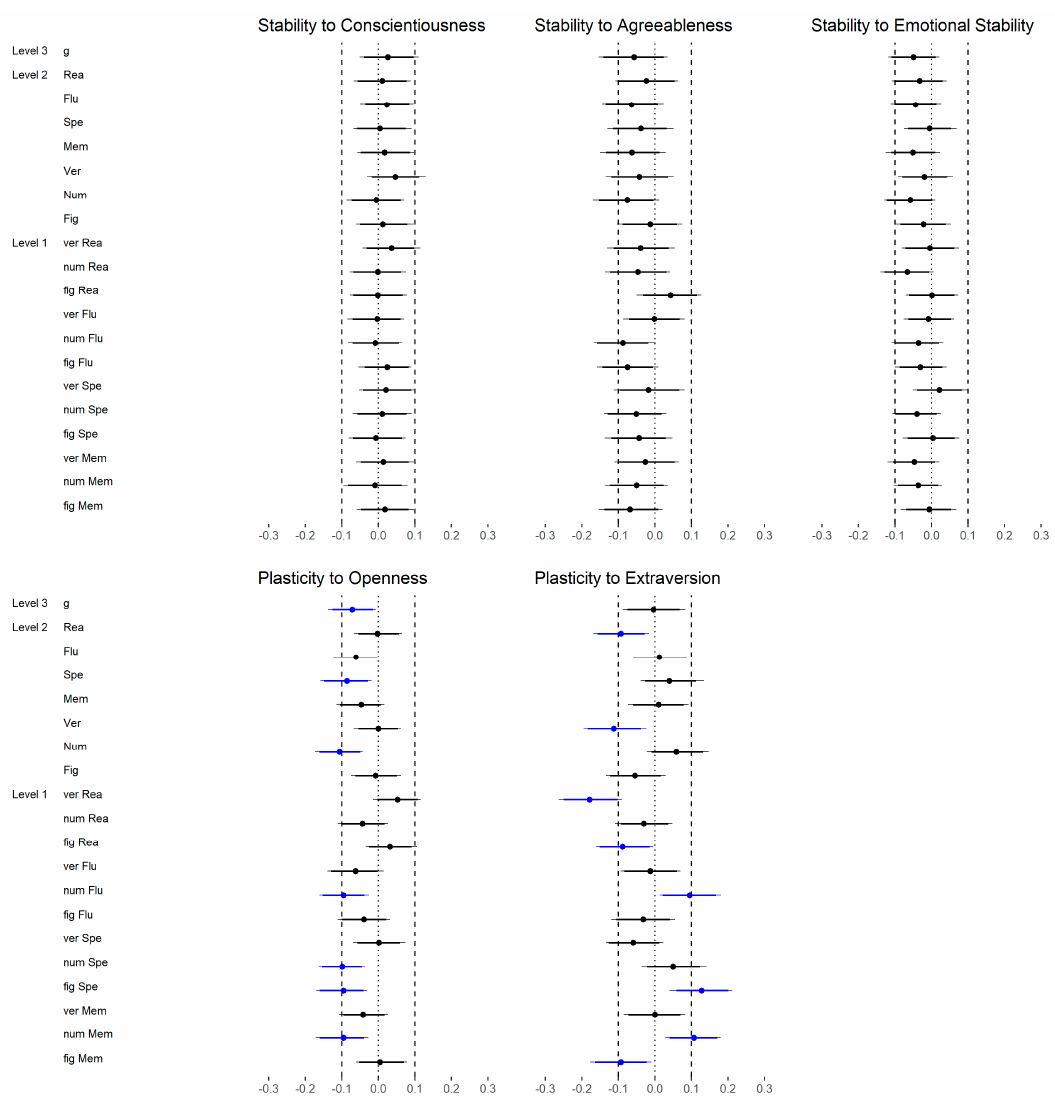
Figure 16. Study 2: Evaluation of the Brunswik Symmetry principle with regard to personality. Change of correlations when FFM dimensions (medium level) were considered instead of the Big Two (high level). Rea = reasoning, Flu = fluency, Spe = perceptual speed, Mem = memory, Ver = verbal (intelligence), Num = numerical (intelligence), Fig = figural (intelligence). Blue lines indicate substantially different correlations based on an equivalence testing approach.